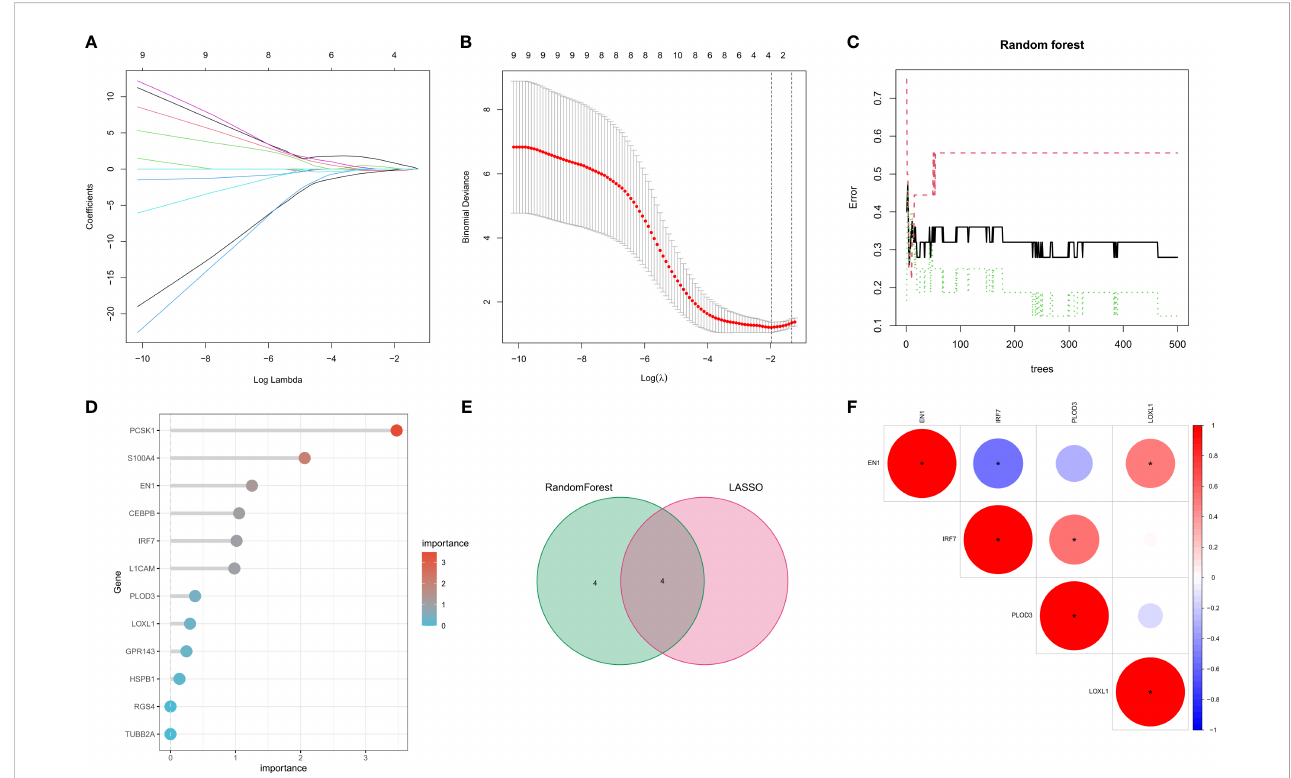
FIGURE 4 Selection of Parkinson ’ s disease-related hallmark genes among NFRGs. (A) Ten cross-validations of the LASSO model ’ s improved parameter selection. Each curve represents on gene. (B) Construction of linear models (Lasso) and visualization by coef fi cients. (C) The best lambda is where vertical dashed lines are drawn. The error rate for random forests with the number of classi fi cation trees. (D) Importance ranking of all selected genes. (E) lasso regression analysis and random forest for the intersection of genes. (F) Spearman correlation analysis of the four NFRGs. *p < 0.05, **p < 0.01, ***p <